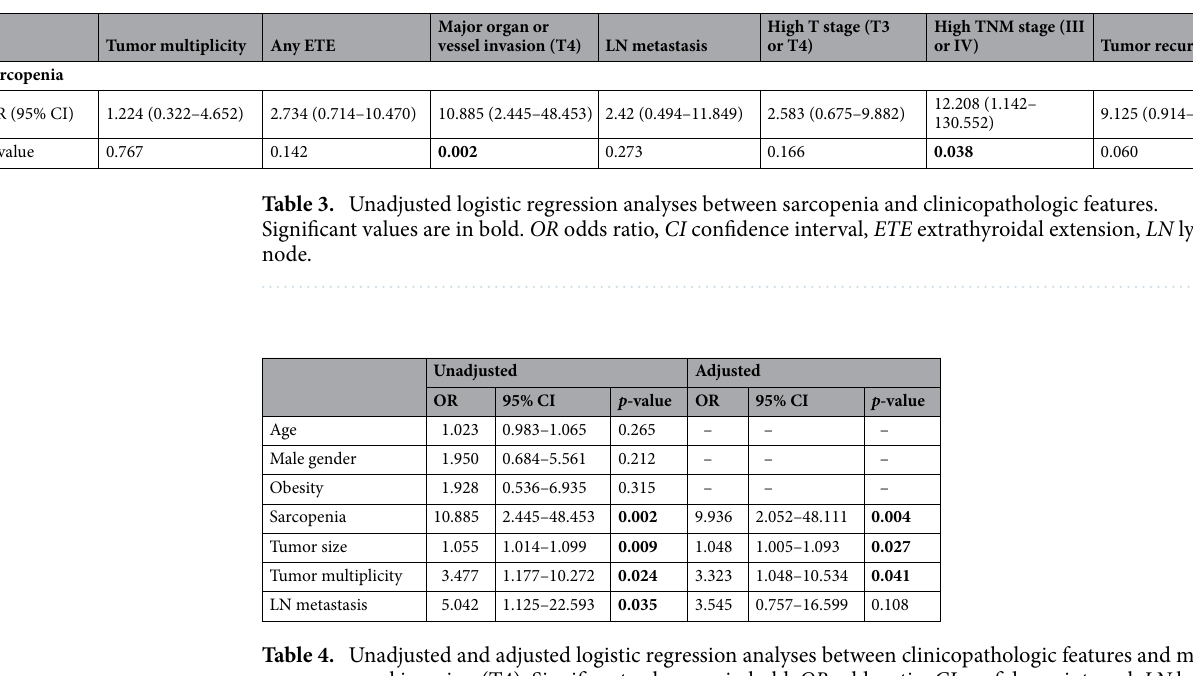
Table 4. Unadjusted and adjusted logistic regression analyses between clinicopathologic features and major organ or vessel invasion (T4). Significant values are in bold. OR odds ratio, CI confidence interval, LN lymph